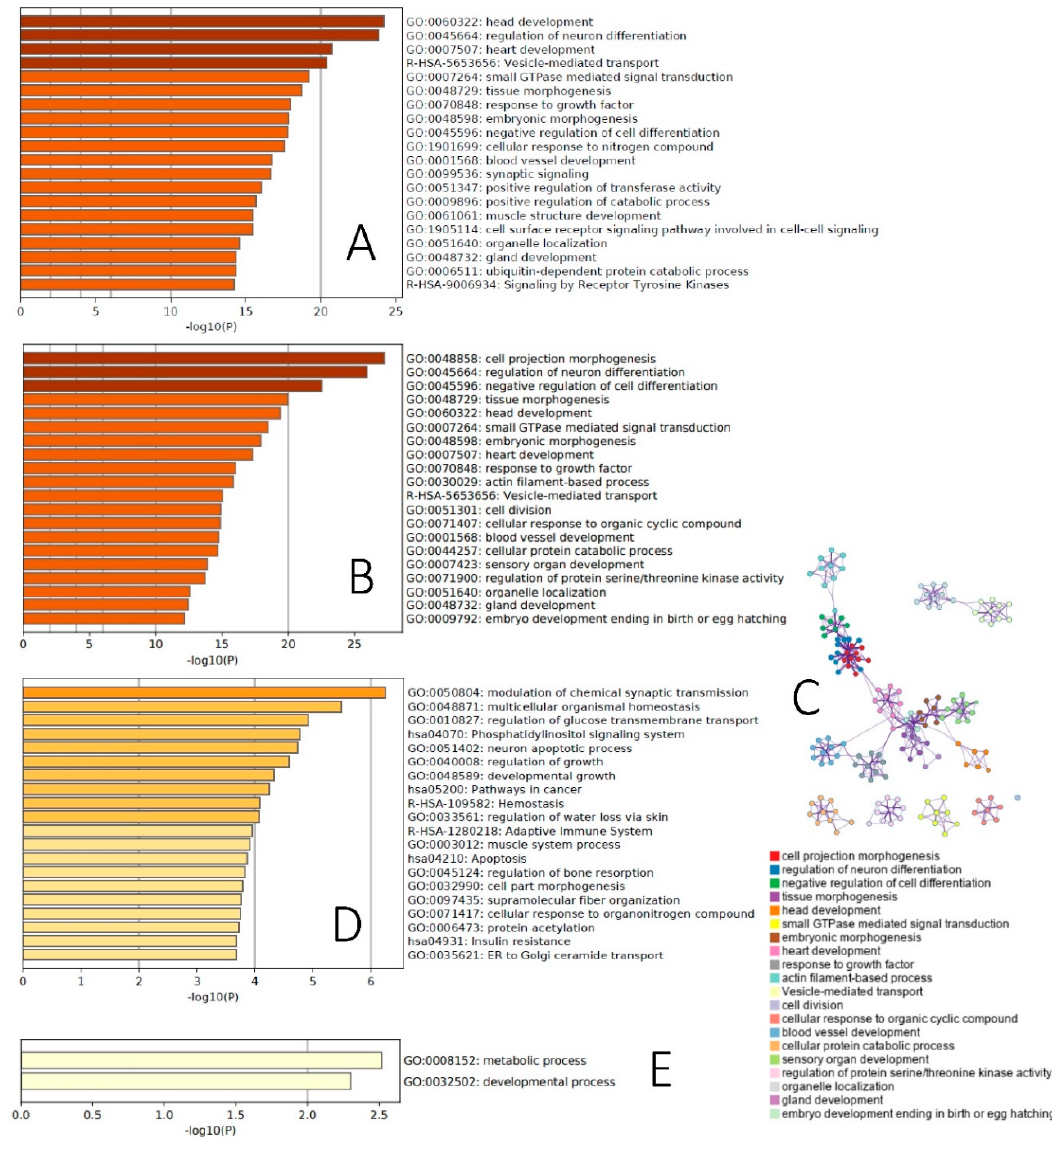
Figure 3. Functional enrichment of di ff erentially expressed sncRNA: ( A )—enrichment of biological categories with 2654 gene targets of ≥ two age-dependent miRNA di ff erentially expressed in control animals, ( B , C )—enrichment of biological categories ( B ) and network of enriched terms ( C ) for 2261 targets of age-dependent miRNA di ff erentially expressed in both control and BDE-47-exposed animals, ( D )—enrichment of biological categories with 688 gene targets of miRNA di ff erentially expressed in BDE-47 animals on PND120, ( E )—enrichment of biological categories with 42 gene targets of piRNA di ff erentially expressed between two age groups of control animals.